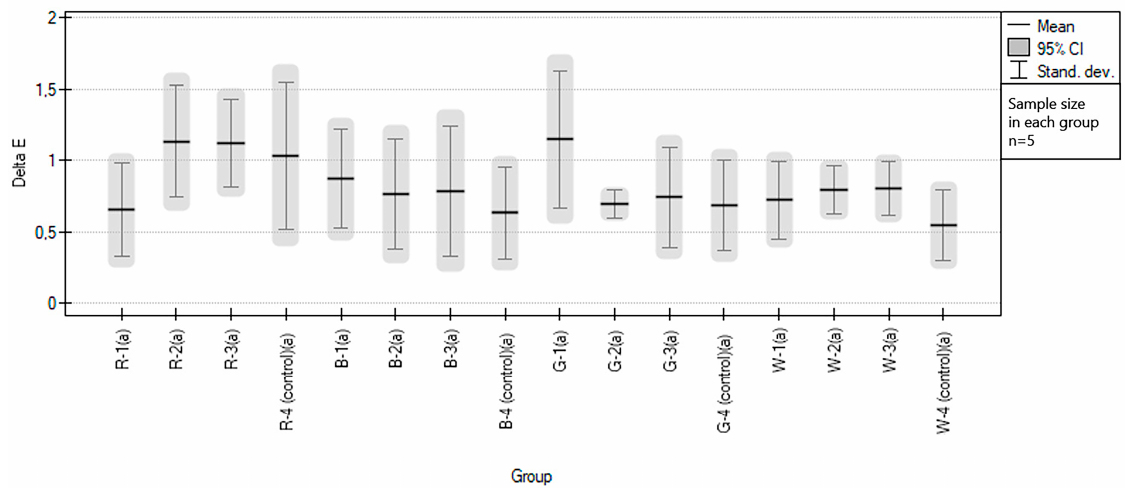
Figure 5. Graphical representation of the results of statistical analysis of the color changes of EVA samples under the influence of sports drinks, divided into groups. The same lowercase letters in brackets after the group code indicate homogeneity between all groups.